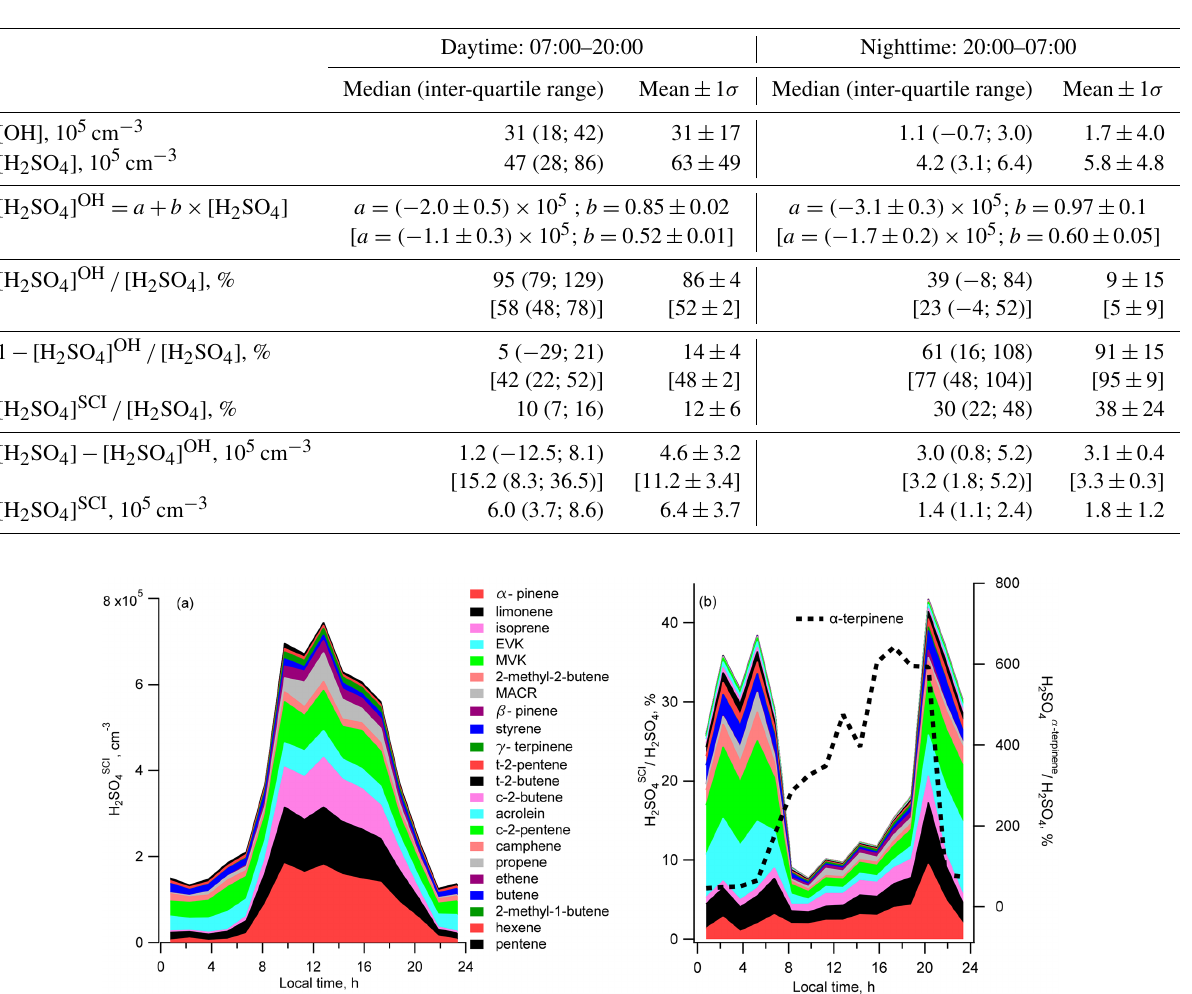
Table 1. Comparison of observed [H 2 SO 4 ] with calculations assuming H 2 SO 4 formation via oxidation of SO 2 by OH and SCIs. [OH] and [H 2 SO 4 ] are observed concentrations, and [H 2 SO 4 ] OH and [H 2 SO 4 ] SCI are calculated H 2 SO 4 produced by oxidation of SO 2 by OH and SCI, respectively. Values in square brackets correspond to [H 2 SO 4 ] OH concentrations calculated with a rate coefficient for the reaction of OH with SO 2 from Medeiros et al. (2018) (see discussion in Sect. 4.2).